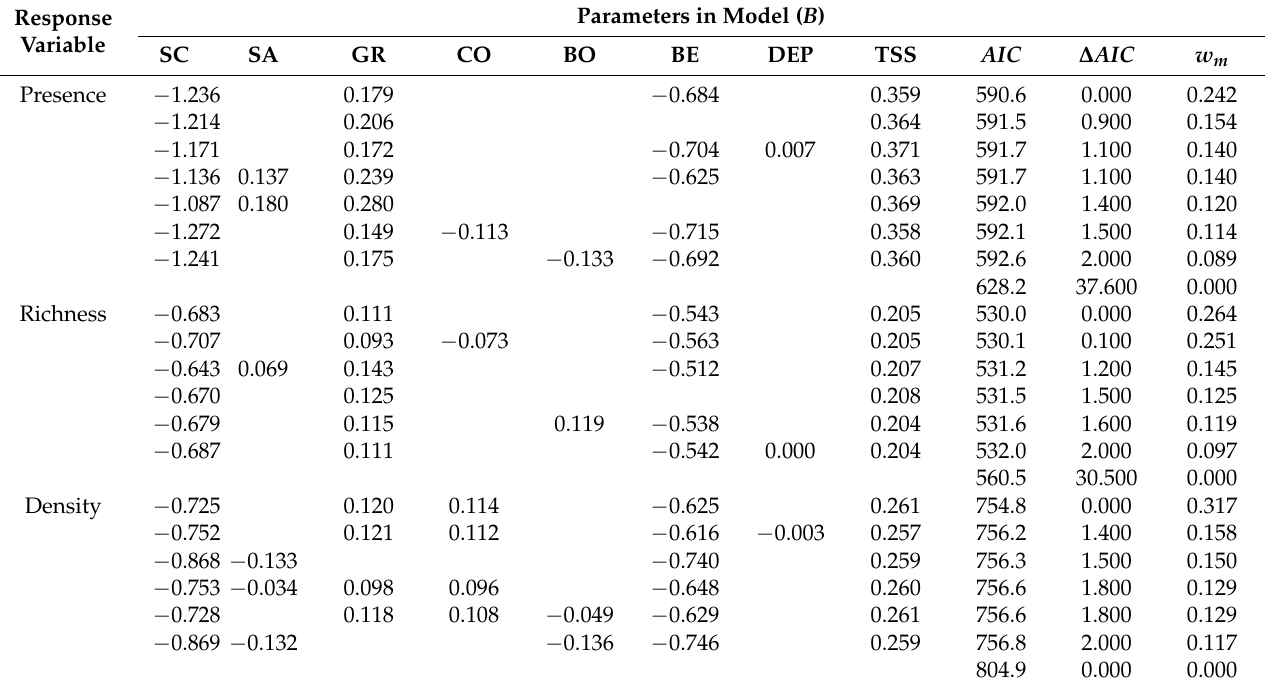
Table 2. Akaike Information Criterion ( AIC ) model selection results for mussel presence, species richness, and density models. All models with ∆ AIC < 2 were included, as well as the null model. ∆ AIC = the difference between the AIC of the best fitting model and the model of comparison. w m = model weights (normalized relative likelihood values). B = parameter coefficients that describe the effect of the independent variable on the response variable. Microhabitat parameters are silt/clay (SC), sand (SA), gravel (GR), cobble (CO), boulder (BO), bedrock (BE), depth (DEP), total total suspended solids (TSS). Benthic velocity and growing degree days were included in model selection but were not considered important in the AIC analyses (see Methods).